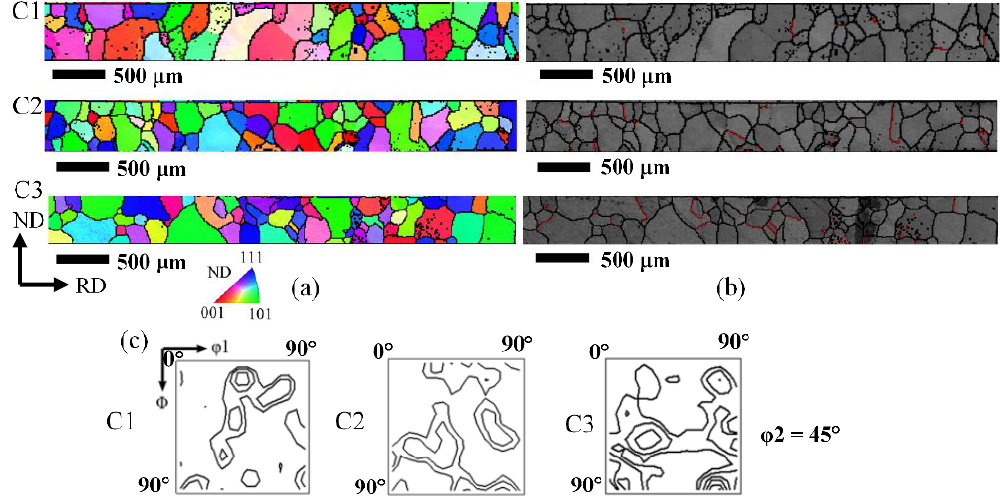
Figure 9. EBSD maps of 2# samples after final transformation treatment by 1150 °C of three conditions C1 to C3 on the 0.5 mm cold rolled sheets with initial columnar grain structure. ( a ) IPF-ND maps; ( b ) band contrast maps with boundary characters (red lines: Σ3); ( c ) ODFs at ϕ 2 = 45° section.